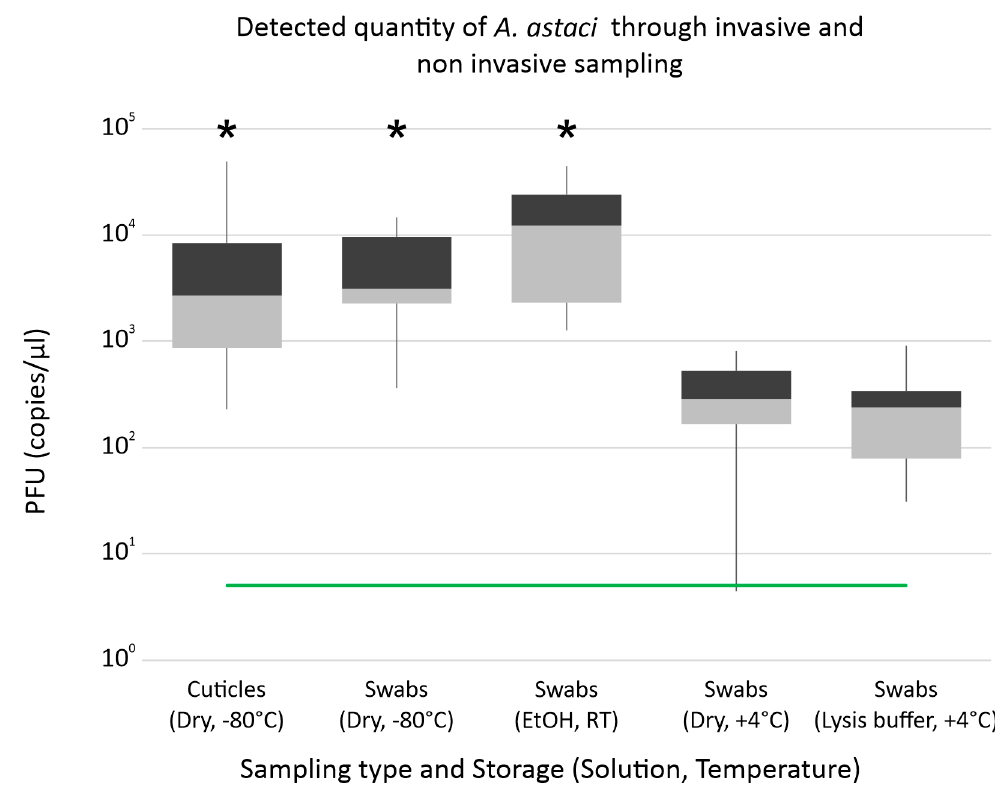
Figure 4. Comparison between storing methods (solution and temperature) in dead and moribund A. pallipes collected during the A. astaci outbreak in Friuli Venezia Giulia. The absolute quantifications are expressed as PCR Forming Units (copies/µL) in qPCR. The green line indicates the LoD level (5.00 copies/µL). *, indicate comparable results.